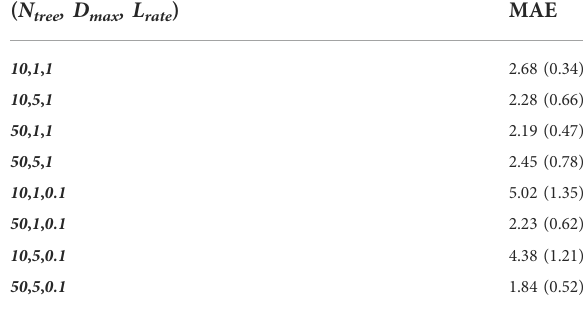
TABLE 3 The MAE and R 2 of different models and different input parameters [mean (sd)]. Models